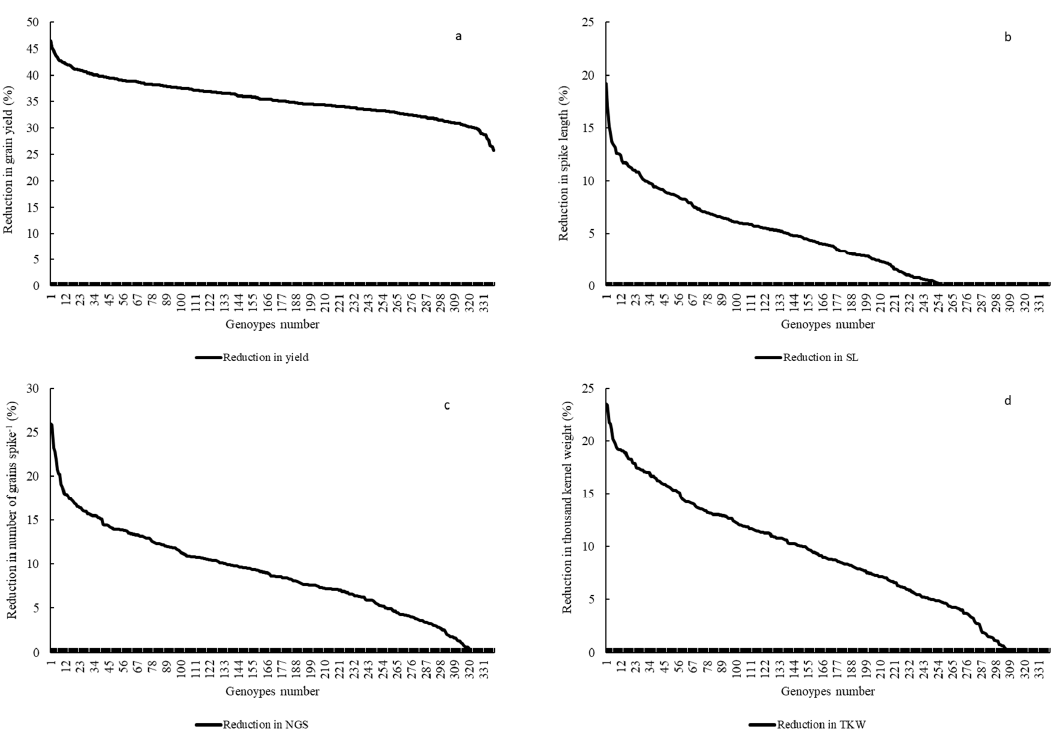
Figure 6. Graphs showing average reduction of di ff erent traits in 339 genotypes for grain yield ( a ), spike length ( b ), number of grains spike − 1 ( c ), and thousand kernel weight ( d ).